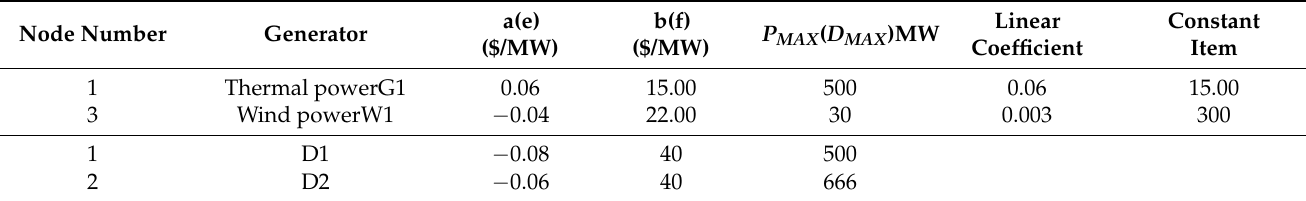
Table 1. Electricity generator and load parameters.